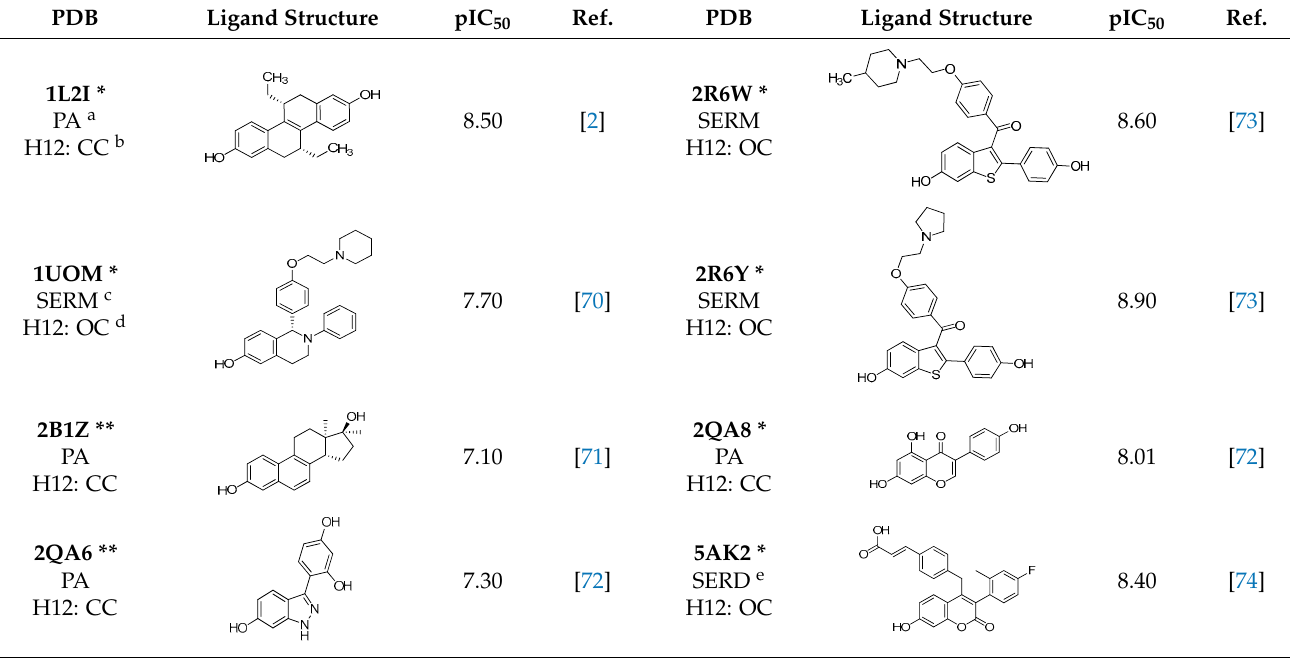
Table 2. PDB codes, ligand structures, and pharmacological profile of mutated (MUT) estrogen receptor α complexed with antagonists and partial agonists; for the 3-D pharmacophore hypothesis generation, compounds were classified into “actives” (PDB codes marked with a star *) and “inactives” (PDB codes marked with a double star **) using a threshold pIC 50 value of 7.30.